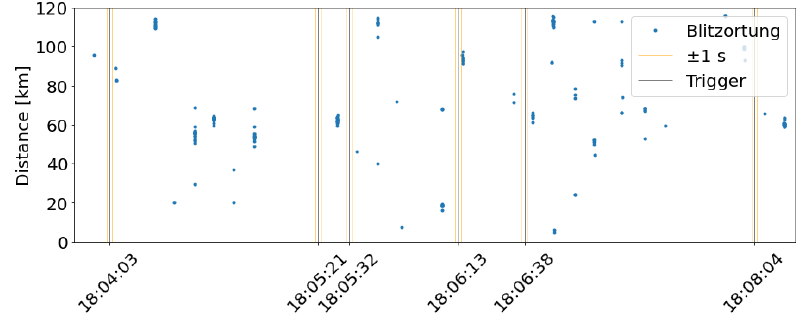
Figure 13. Correlation with “close” (less than 20km) lightning detection.